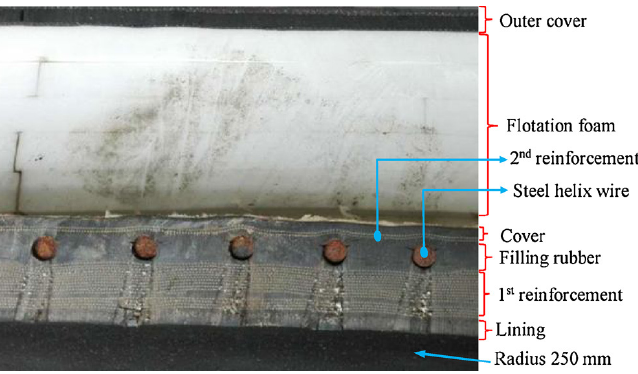
Figure 2. Typical configuration of a bonded composite hose body [5].